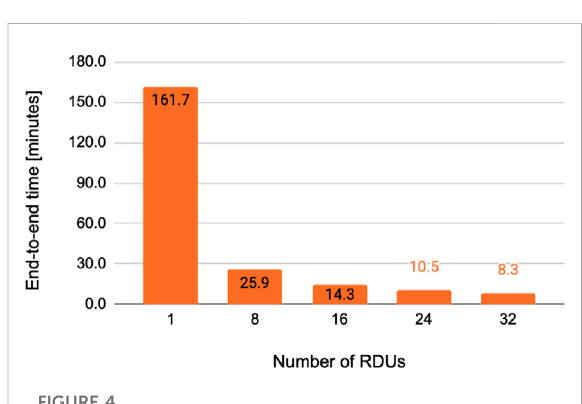
FIGURE 4 Variation of the end-to-end training time with the number of RDUs. This end-to-end time begins with the loading of data from system memory, includes 51 epochs of training into convergence (no early stopping), and return of trained model back to systemmemory. Resultsareshown usinga fi xedLBSof128andup to 32